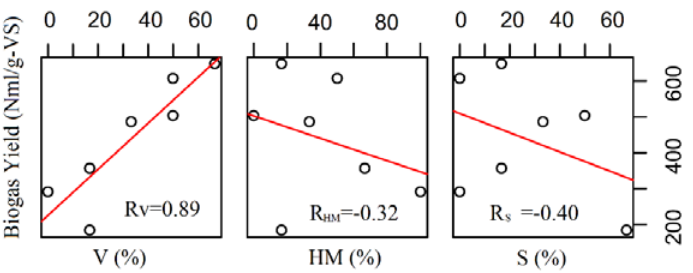
Fig. 3: Correlation coefficients of biogas yield with ratios of every material